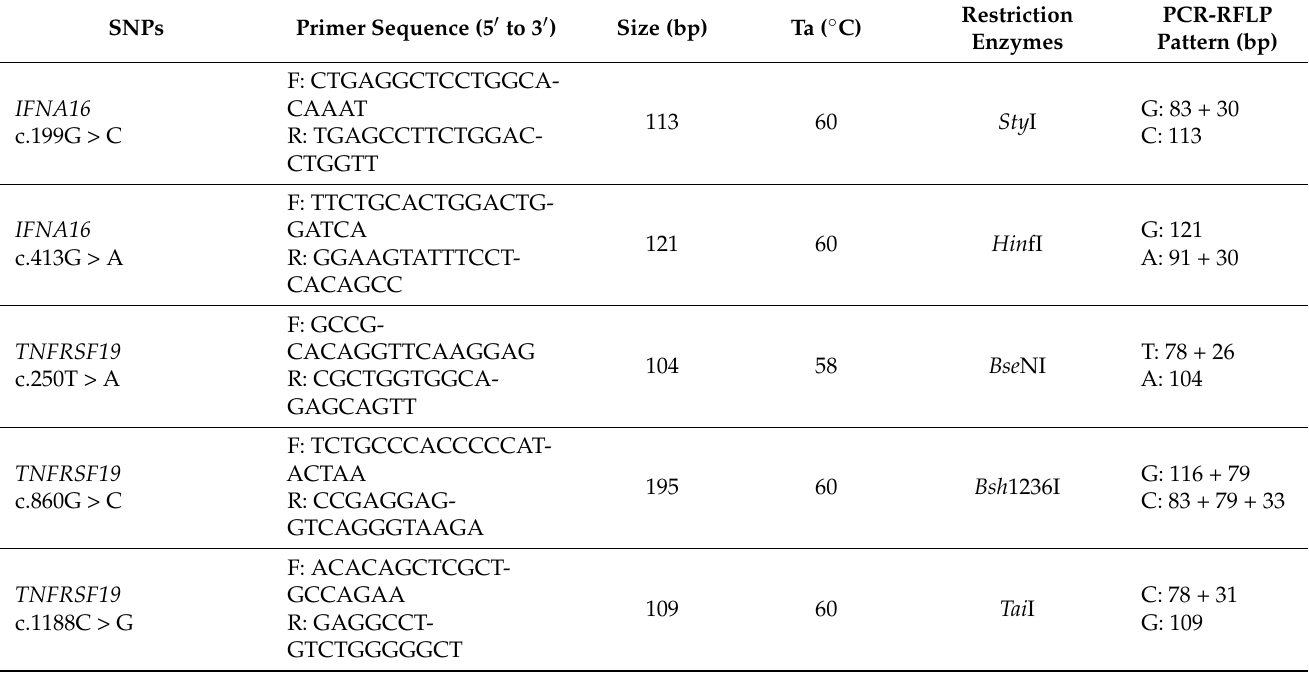
Table 1. Primer sequences and restriction enzymes used to detect polymorphisms of porcine IFNA16 and TNFRSF19 genes and the pattern of PCR-RFLP fragment sizes; Ta, annealing